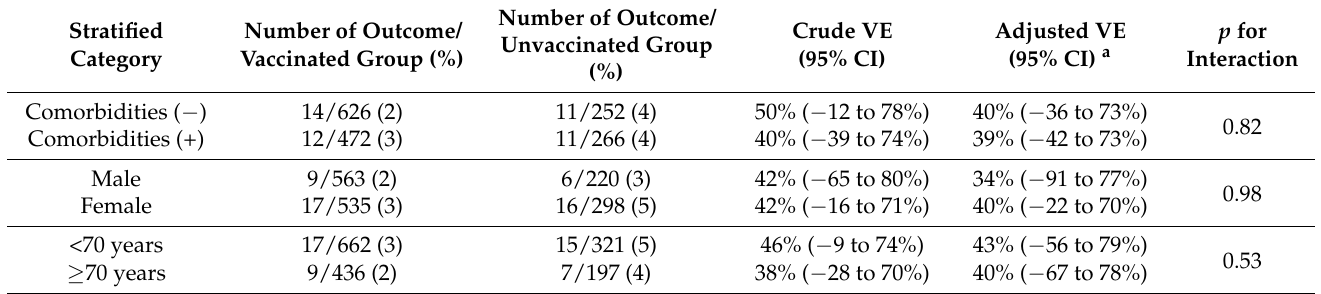
Table 4. Vaccine effectiveness against HZ in the stratified